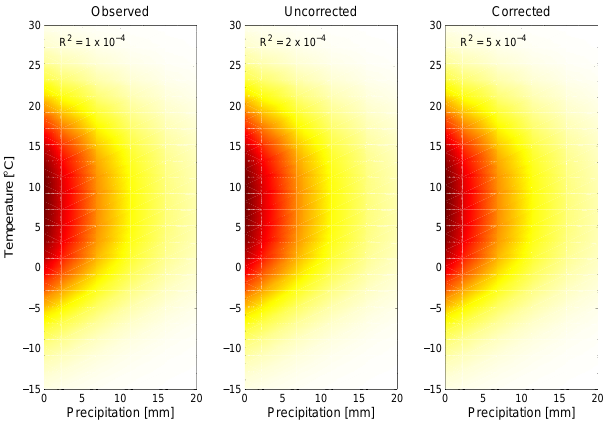
Fig. 13. Dependency between the daily precipitation and tempera- ture of the observed and uncorrected and corrected ERA15/REMO data for the period 1979–1995. The squared correlation coefficient for the correlation between precipitation and temperature is shown as well.